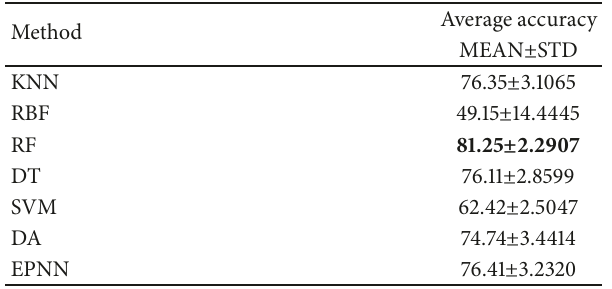
Table 14: Classification performance of EPNN in comparison with other classification methods on Distress